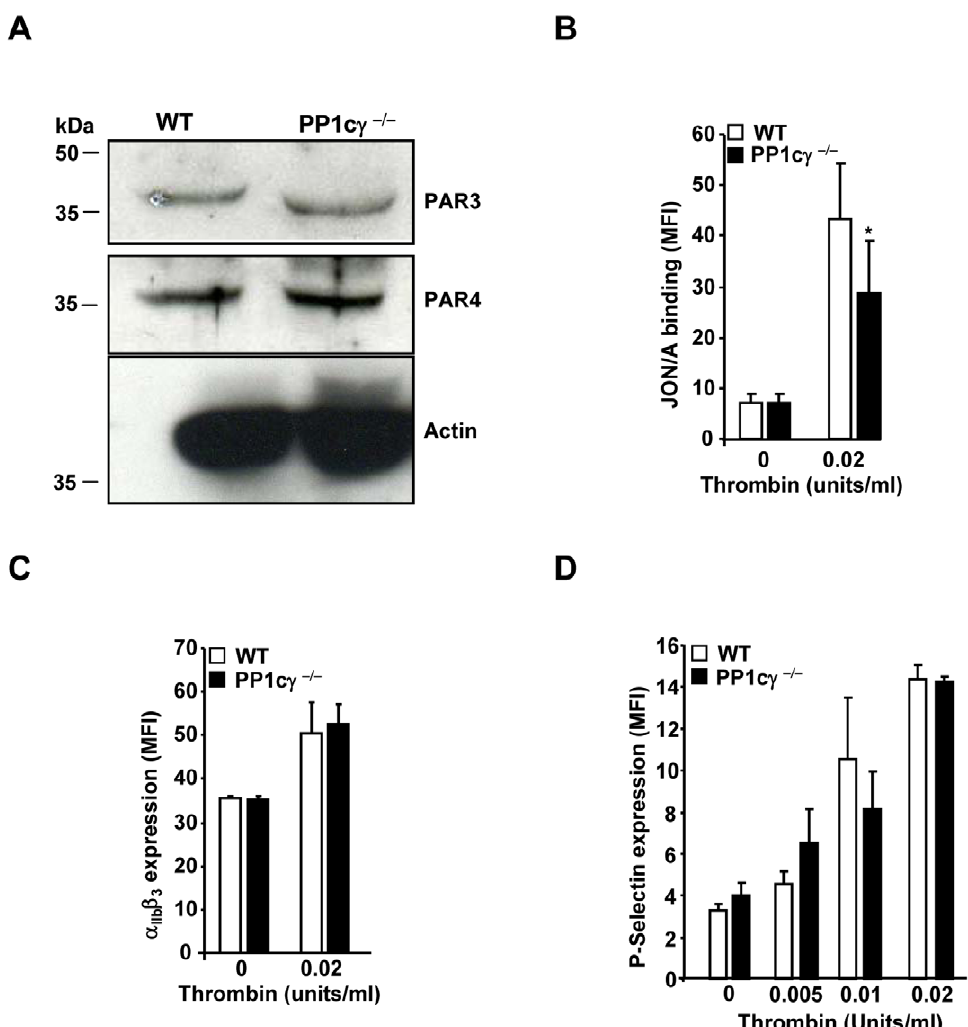
Figure 3. Expression of thrombin receptors, a IIb b 3 and P-selectin in PP1c c 2 / 2 platelets. ( A ) Lysate from resting washed platelets was evaluated by SDS-PAGE and immunoblotted with anti-PAR3 antibody ( , 43 kDa). The blot was stripped and reprobed with anti- PAR4 ( , 38 kDa) and then with anti-actin (loading) antibodies. Blots are representative of two experiments. Washed platelets were incubated with anti-JON/A PE antibody ( B ) or anti- a IIb FITC antibody ( C ) or anti-P-selectin antibody ( D ) and subjected to flow cytometry. Results are expressed as 6 SEM of 5–6 experiments. Compared to thrombin stimulated WT platelets, the decreased binding of JON/A antibody to PP1c c 2 / 2 platelets was significant at *p=0.003.